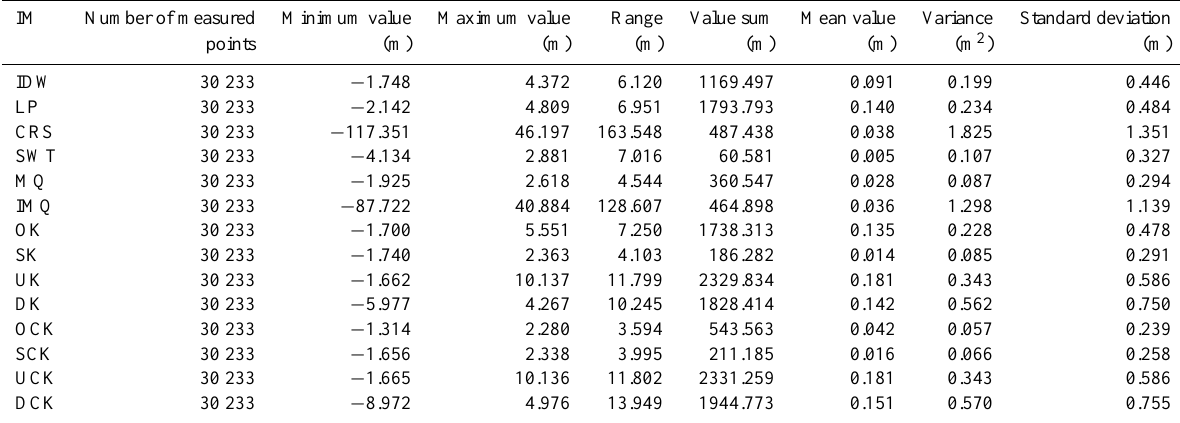
Table 4. Cross-validation results calculated for elevation data from two data sets, but statistic indicators are only for points gathered by bathymetric